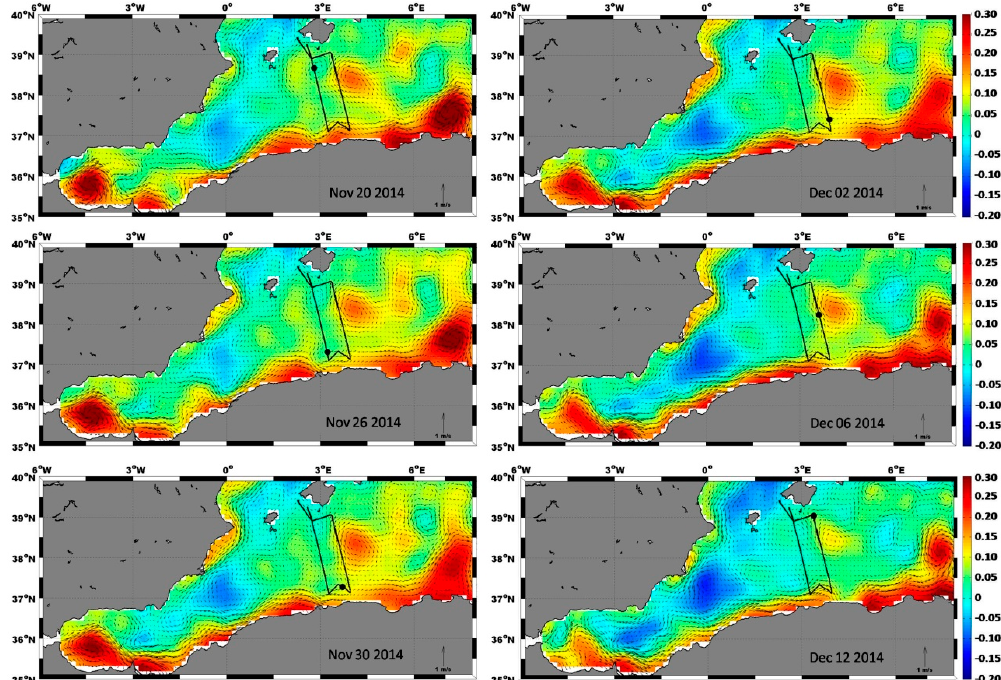
Figure 10. All-sat-merged AVISO ADT maps of the Alboran Sea and the Algerian Basin on six representative dates of the ABACUS 1.2 survey. Glider track in black. Large black dots represent glider location on each date. Geostrophic currents are represented through black arrows. ADT in